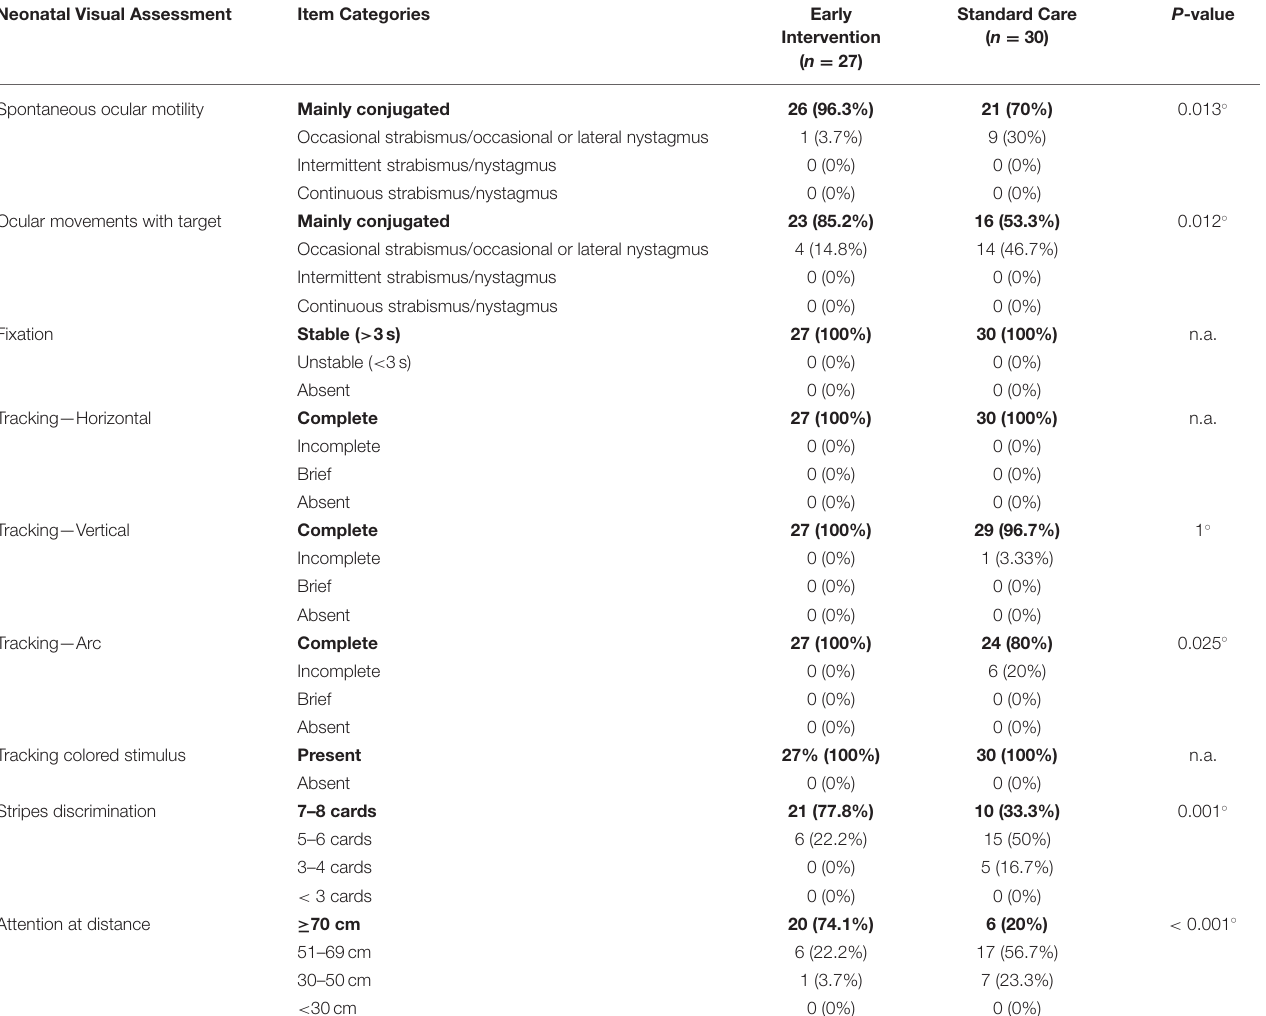
TABLE 2 | Visual assessment in the two groups. Neonatal Visual